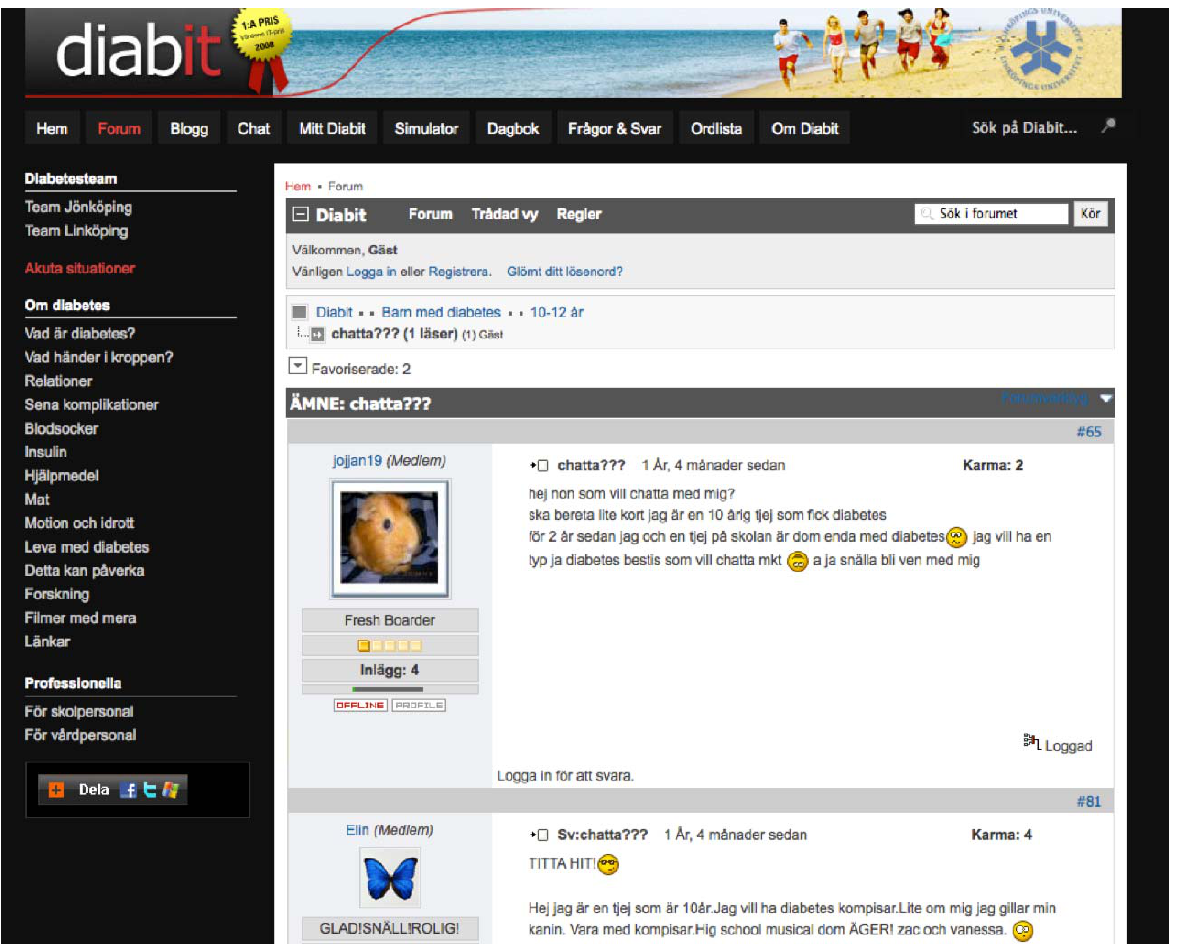
Figure 2. A sample discussion forum